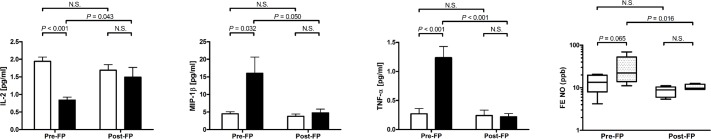
Inhaled fluticasone propionate increases IL-2 and decreases MIP-1β, TNF-α, and exhaled NO.Comparison of IL-2, MIP-1β, TNF-α, and exhaled NO between AP1 and AP2 pre- and post-six weeks of fluticasone propionate (FP) treatment. Comparison was performed using two-way ANOVA and Tukey’s post-hoc t-test, P < 0.05 was considered significant. Cytokines shown as mean and error bars represent standard error of mean. Boxplot represent the median and quartiles. Exhaled NO was log10 transformed for normalization.